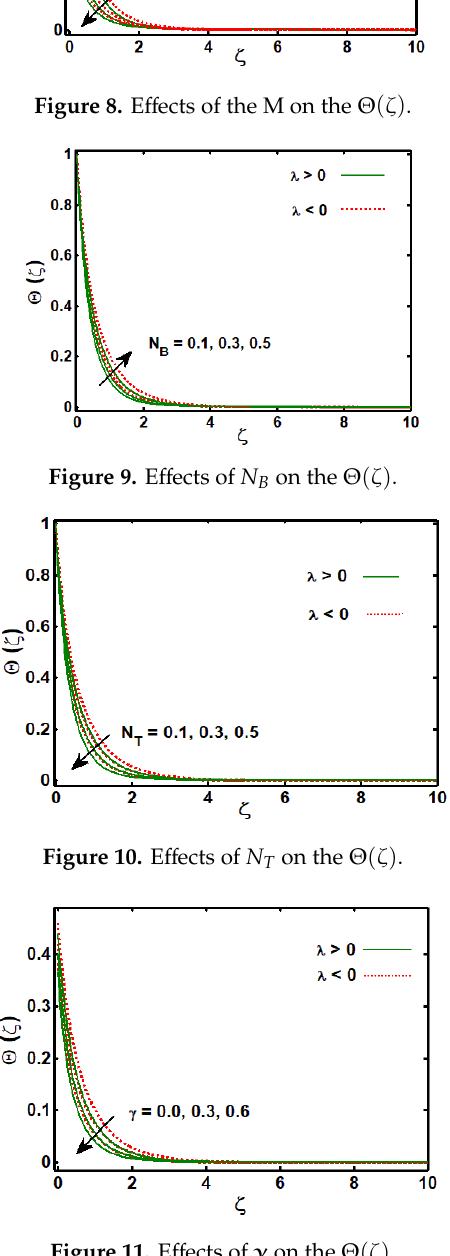
Figure 11. E ff ects of γ on the Θ ( ζ ) Figure 11. Effects of 𝛄 on the 𝜣(𝜻) . Figure 11. Effects of 𝛄 on the 𝜣(𝜻) . Figure 11. Effects of 𝛄 on the 𝜣(𝜻) . Figure 11. Effects of 𝛄 on the 𝜣(𝜻) .